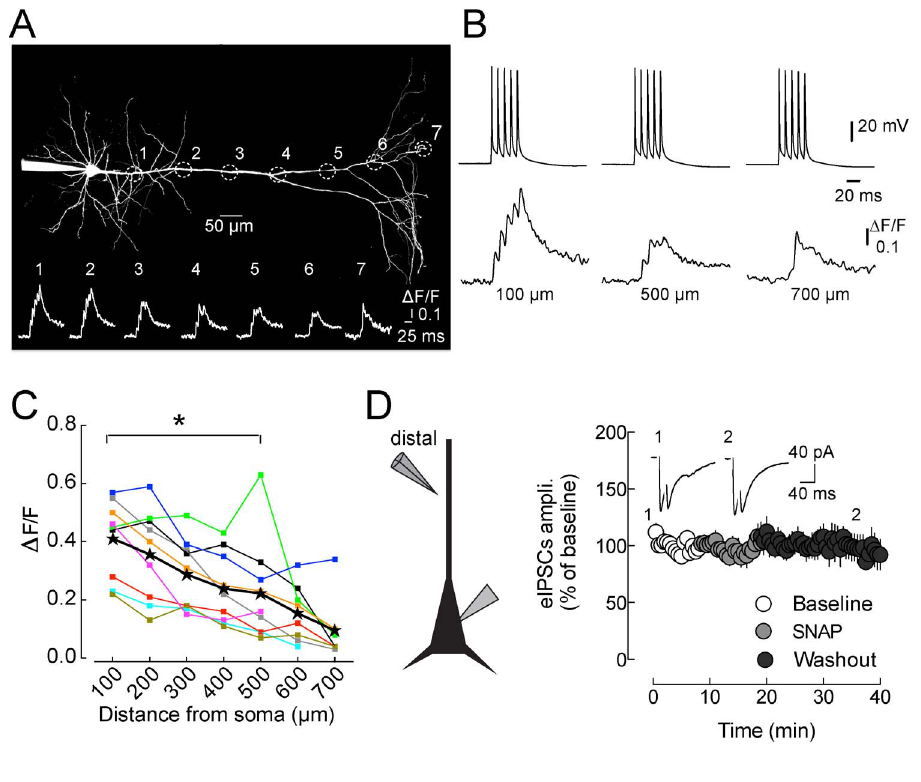
Figure 8. Pyramidal neuron dendritic Ca 2 + dynamics and lack of NO sensitivity of distal GABAergic synapses. (A) 2PSLM image (maximal intensity projection) of a layer 5 pyramidal neuron loaded with Alexa 594 (20 m M) and the Ca 2 + indicator OGB-5N (300 m M). Circles and their diameter indicate dendritic recording locations ( , 100 m m apart) and approximate dendritic length over which Ca 2 + transients (in response to 5 APs at 100 Hz) were measured. Inset illustrates representative Ca 2 + transients (average of 10 trials each) recorded from locations indicated in (A). (B) Representative traces of somatically recorded APs (Top) and corresponding calcium transients recorded at different distances from soma. Note the clear calcium spike recorded at 700 m m from soma. (C) Summary plot showing the peak D F/F of bAP-induced Ca 2 + transients for individual cells as a function of distance from the soma. Each color represents one cell, and stars represent population average values. (D) Time course of dendritic IPSCs recorded from layer 5 pyramidal neurons in the presence of the NO donor SNAP (200 m M for 10 min) and the continuous presence of the nonselective phosphodiesterase inhibitor IBMX (200 m M) and glutamate receptor antagonist DNQX (10 m M). IPSCs were evoked by stimulating GABAergic afferents on pyramidal neuron distal dendrites ( , 500 m m from the soma). White, light grey, and grey symbols refer to control, SNAP, and washout periods, respectively. The inset illustrates representative IPSC traces at the two indicated time points (1 and 2).